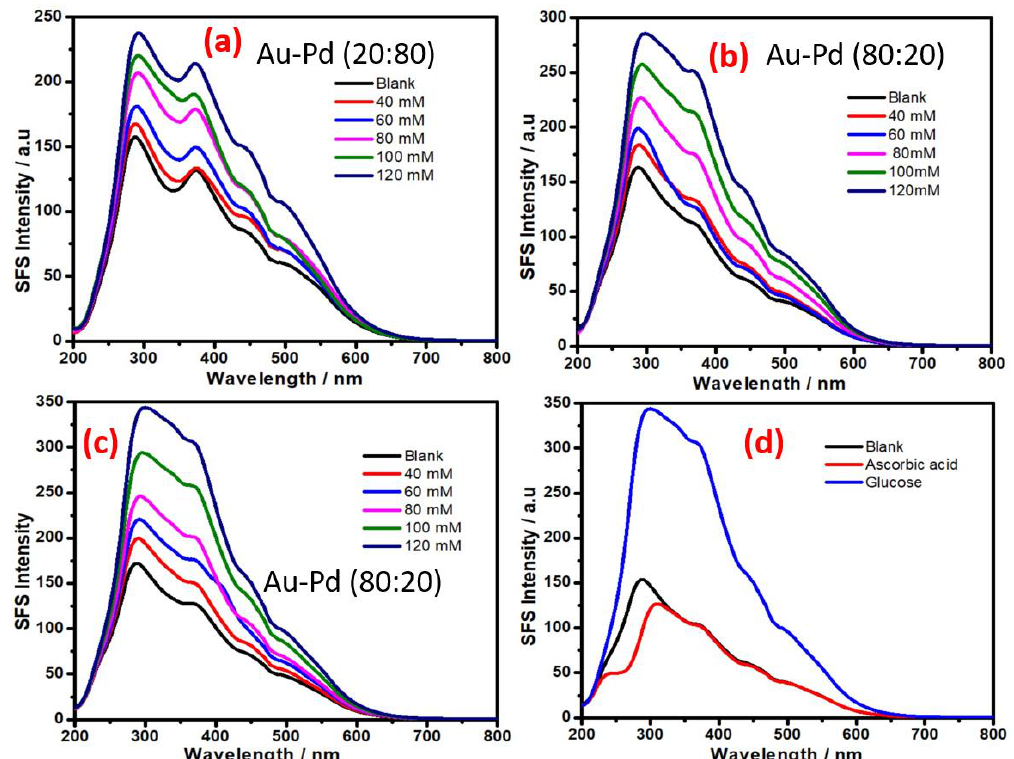
Figure 5. Synchronous fluorescence spectra at delta δλ = 0 nm; the spectra were recorded at various concentrations of glucose. ( a ) Synchronous fluorescence intensity of bimetallic (Au-Pd) NPs with an Au:Pd ratio of 20:80. ( b ) Synchronous fluorescence intensity of bimetallic (Au-Pd) NPs with an Au:Pd ratio of 80:20. ( c ) Synchronous fluorescence intensity of bimetallic (Au-Pd) NPs with an Au:Pd ratio of 80:20 with Nafion. ( d ) Synchronous fluorescence intensity of bimetallic (Au-Pd) NPs with an Au:Pd ratio of 80:20 with Nafion in the presence of glucose and ascorbic acid.